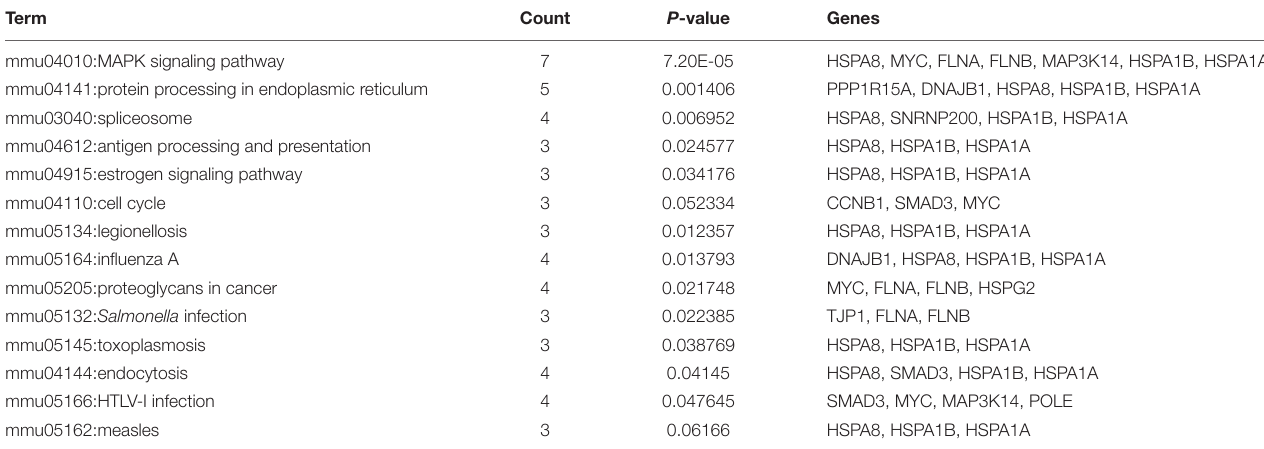
TABLE 4 | KEGG enrichment analysis on SKOV3 and COV434 common deregulated genes. Term Count P -value Genes mmu04010:MAPK signaling pathway